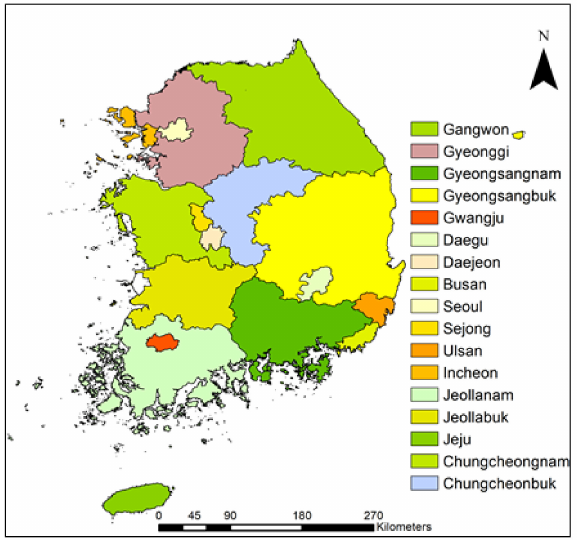
Figure 1. Administrative divisions (major cities and provinces) and geographical boundaries of South